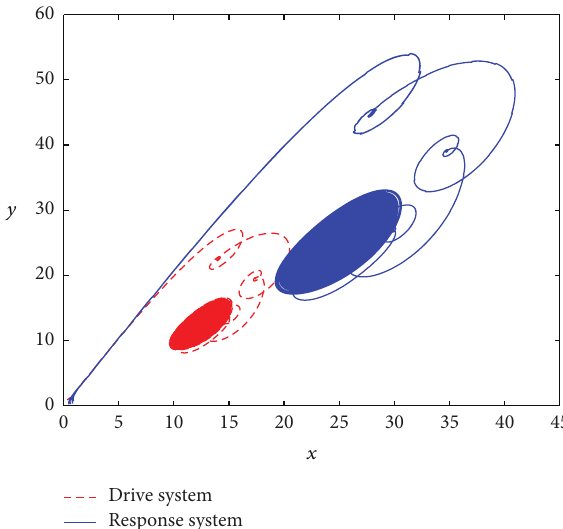
Figure 3: The phase plot of 𝑥 and 𝑦 plane with 𝛼 = 2 .